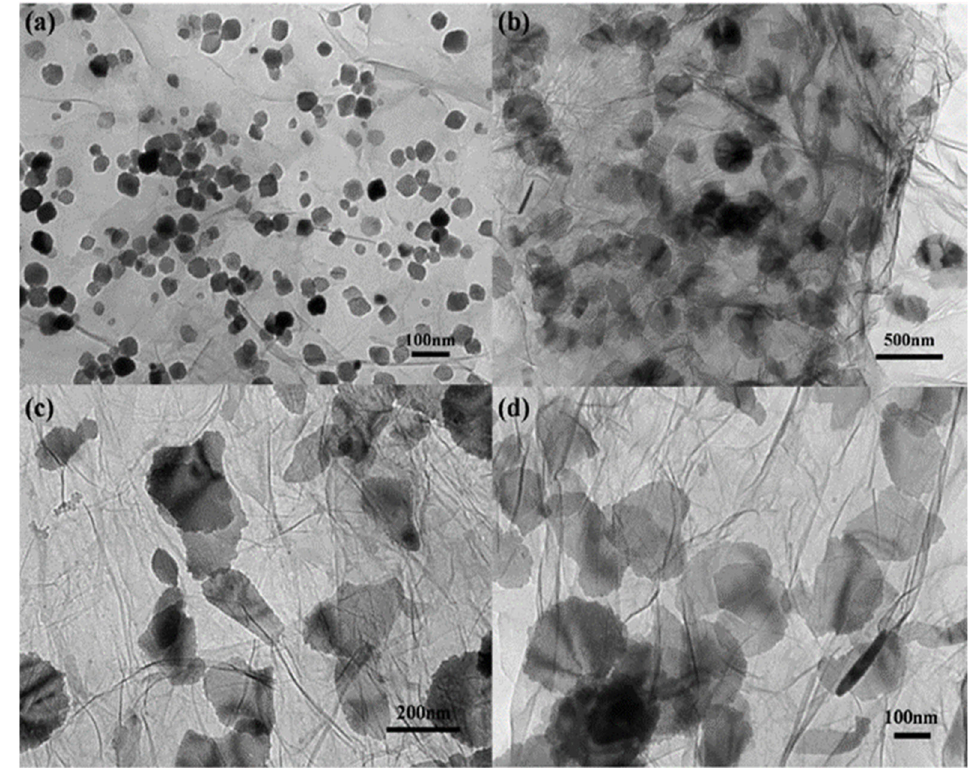
Figure 13. The morphological analysis of Fe 2 O 3 –graphene nanocomposites by TEM. TEM images of ( a ) Fe 2 O 3 –graphene particle-on-sheet composite, and ( b – d ) Fe 2 O 3 –graphene sheet-on-sheet compo- site with stepwise increased magnifications [173] (CC BY).